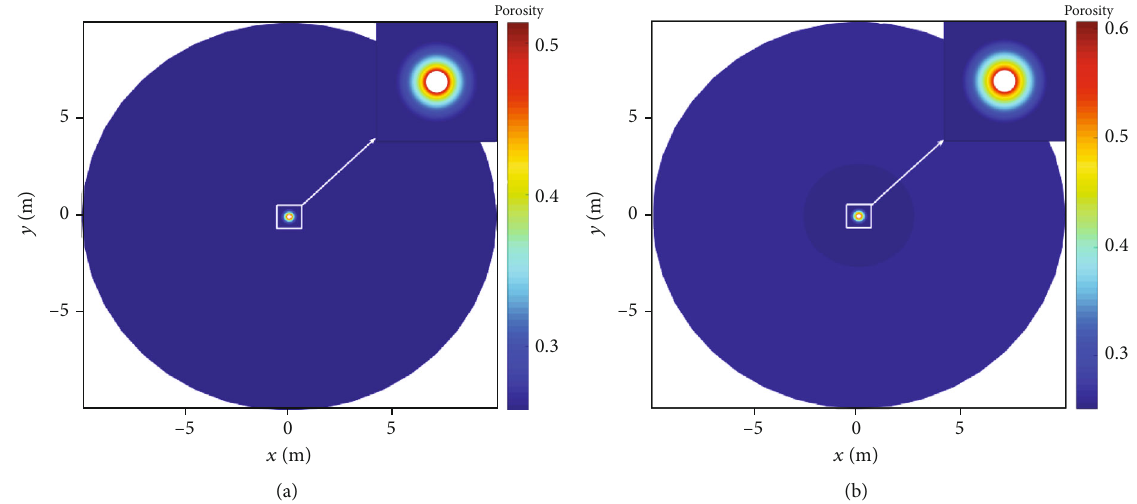
Figure 8: Porosity distribution in homogeneous formation after fl uid injection. (a) t = 2500s . (b) t = 5000 s .